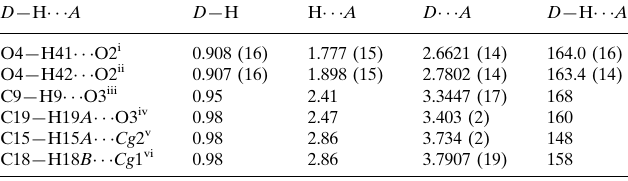
Data collection Bruker Kappa APEXII CCD area- detector diffractometer Absorption correction: multi-scan ( SADABS ; Bruker, 2005) T min = 0.817, T max = 0.942 Refinement